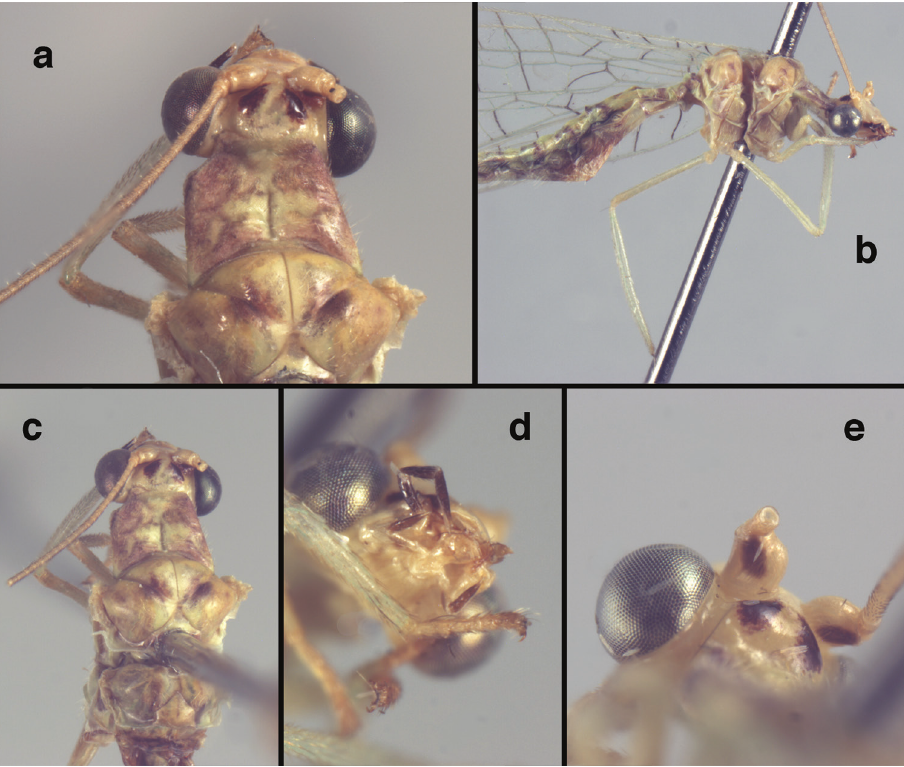
Figure 44. Ungla grandispiracula Tauber, sp. n. External features, ( a ) head, prothorax, mesothorax, dorsal ( b ) thorax, lateral ( c ) thorax, dorsal ( d ) head, ventral ( e ) scapes, dorsal (all: Colombia, Antioquia, USNM; a, c female, paratype; b, d, e male, holotype). Prothorax yellowish mesally, with broad, diffuse, reddish brown, longitudinal, lateral stripes, extending to lateral margin; transverse furrow in mesal region, almost reaching lateral margins; dorsal surface with thin, pale setae, sparse mesally, denser lat- erally. Mesothorax, metathorax marked with reddish brown laterally, yellow mesally; both with pair of brown spots on margin between prescutum and scutum (smaller on metathorax), pair of small brownish spots laterally. Measurements: head width: 1.5 mm; ratio head width : eye width: 2.3 : 1; prothorax width: 1.0 mm; length: 0.5 mm. Forewing with apex rounded, hindwing acute; membrane clear, hyaline, without fumose areas, with venation slender (female) to very slightly crassate (male); stigma lightly opaque to clear, with three to four light brown subcostal crossveins below stig- ma, area surrounding crossveins unmarked; longitudinal veins light green, all costal, radial crossveins brown to brownish; transverse veins in posterior sector of wing brown to pale; gradates dark brown without suffusion. First gradate vein meeting Psm. Fore- wing 12.6–13.7 mm long, 4.3–4.8 mm wide (ratio, L : W = 2.9 : 1); height of tallest costal cell 0.7–0.8 mm (cell number 5–6); length of first intramedian cell 0.9–1.0